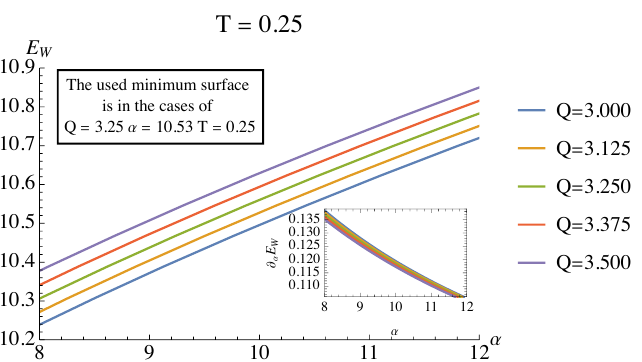
Figure 14 . The EWCS vs α in different values of Q and the configuration ( a, b, c ) is (0 . 6 , 0 . 1 , 0 . 3) when fixing the minimum surface and varying the background